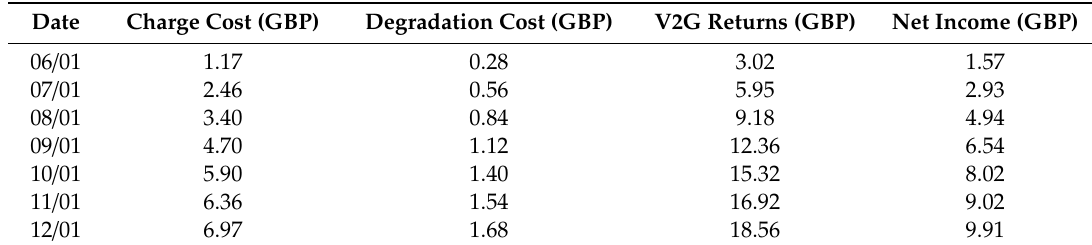
Table 7. Cumulative financial results of the V2G simulation while utilising net billing across a week